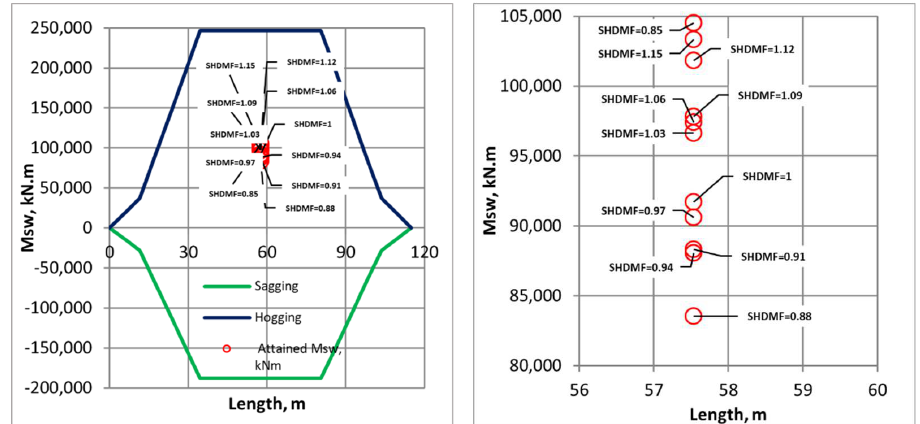
Figure 8. Steel water vertical bending moment at midship section, Msw , regular scale ( left ) and magnified scale ( right ).